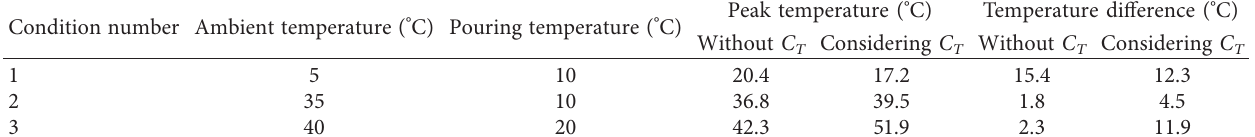
Table 1: The calculation results under different conditions.